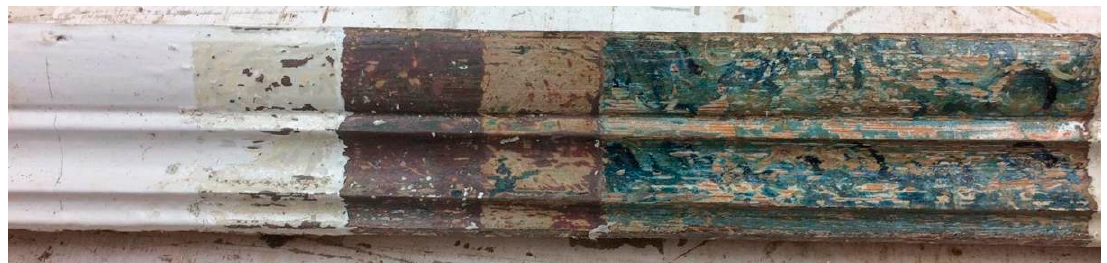
Figure 15. Stratigraphical analysis of the wooden moldings (entrance door, first room).